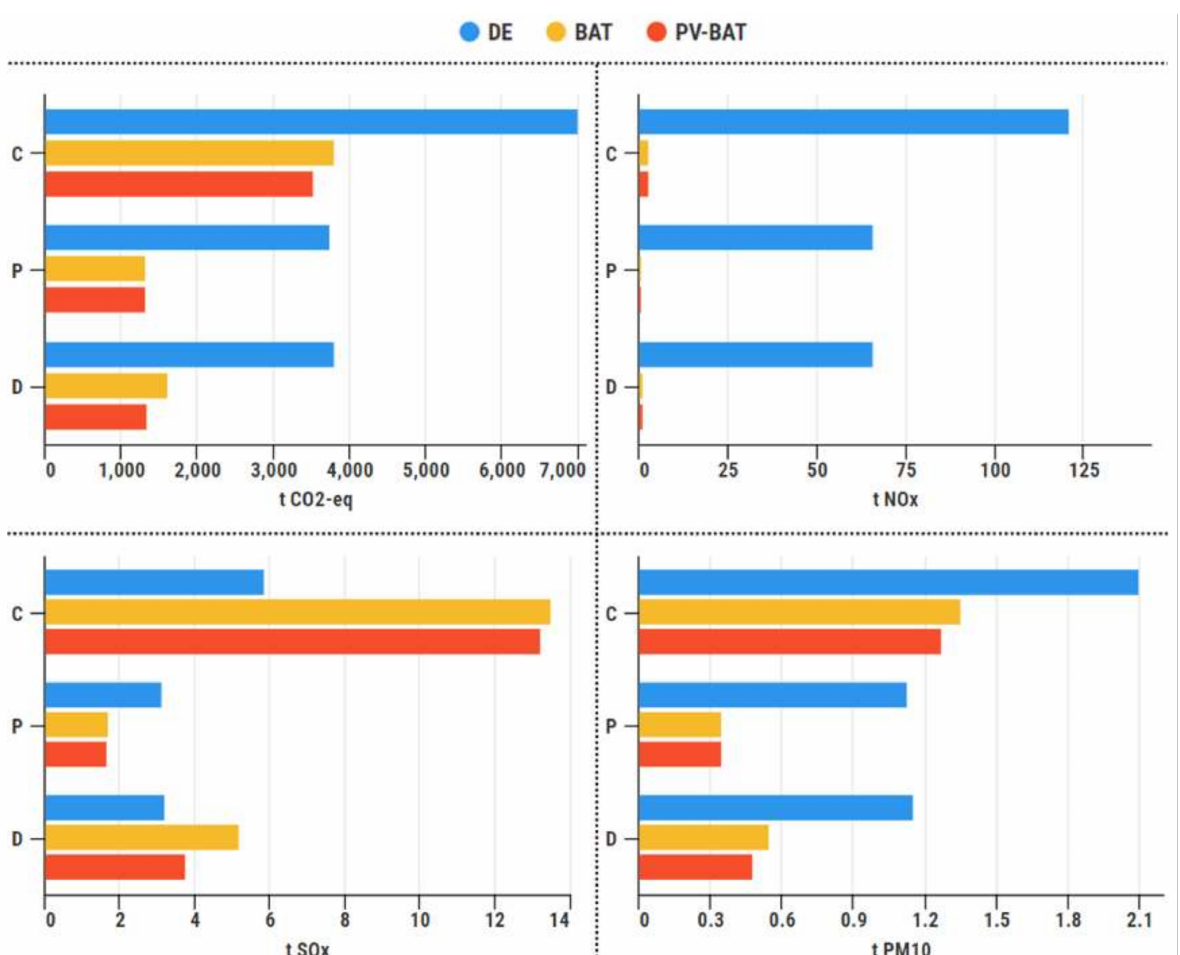
Figure 11. Lifetime emissions of the considered ships with different power system